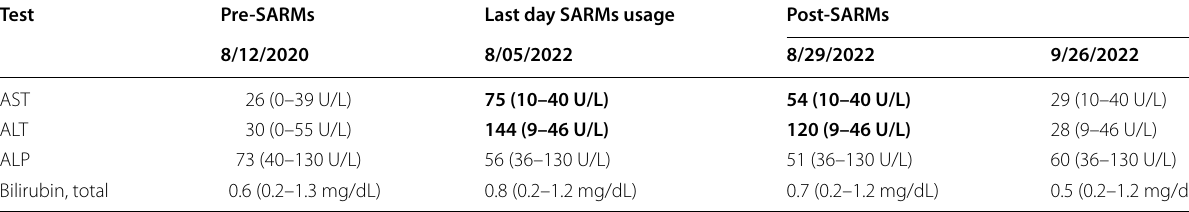
Bold indicates value out of normal range